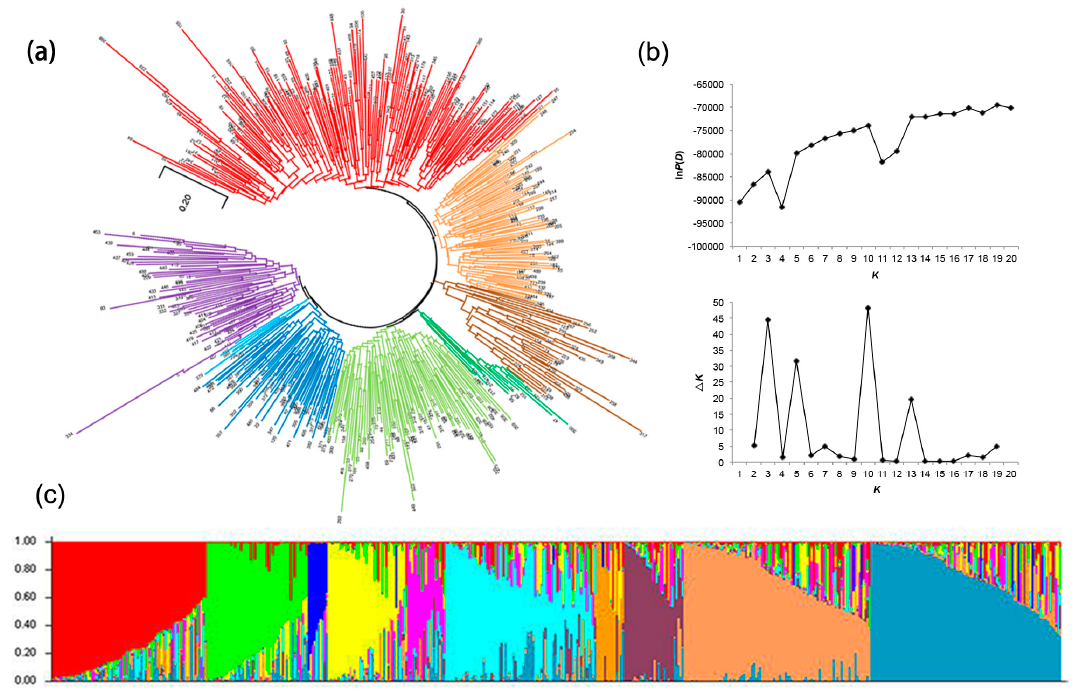
Figure 1. Genetic diversity and population structure analysis of 507 sweet potato germplasms. ( a ) The 507 germplasms could be divided into eight subgroups based on neighbor-joining (NJ) clustering. The different colored lines represent the subgroups inferred by NJ cluster analysis. ( b ) STRUCTURE estimation of the number of subpopulations for K ranging from 1 to 20 by LnP (D) did not show a clear cut-off point for the true K value, and delta K values ( △ K ) indicating the presence of ten subpopulations; ( c ) Ten subpopulations in the 507 germplasms inferred from population structure analysis. The vertical coordinate of each subgroup indicates the membership coefficient of each individual, and the colors of the bar indicate the ten subpopulations identified using STRUCTURE.